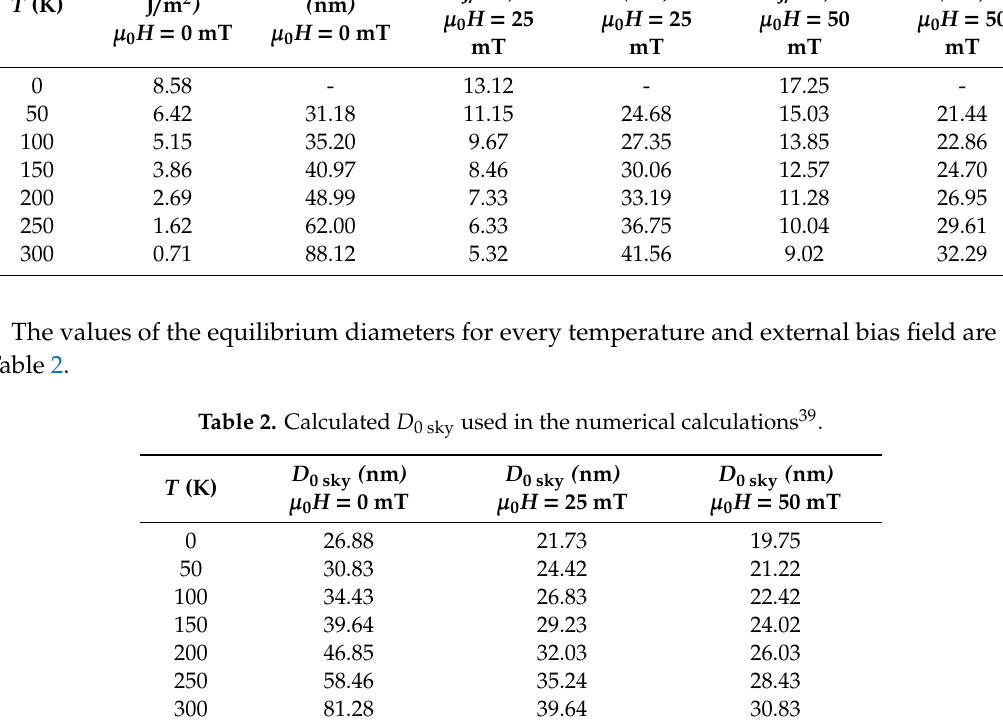
Table 2. Calculated D 0 sky used in the numerical calculations 39 .